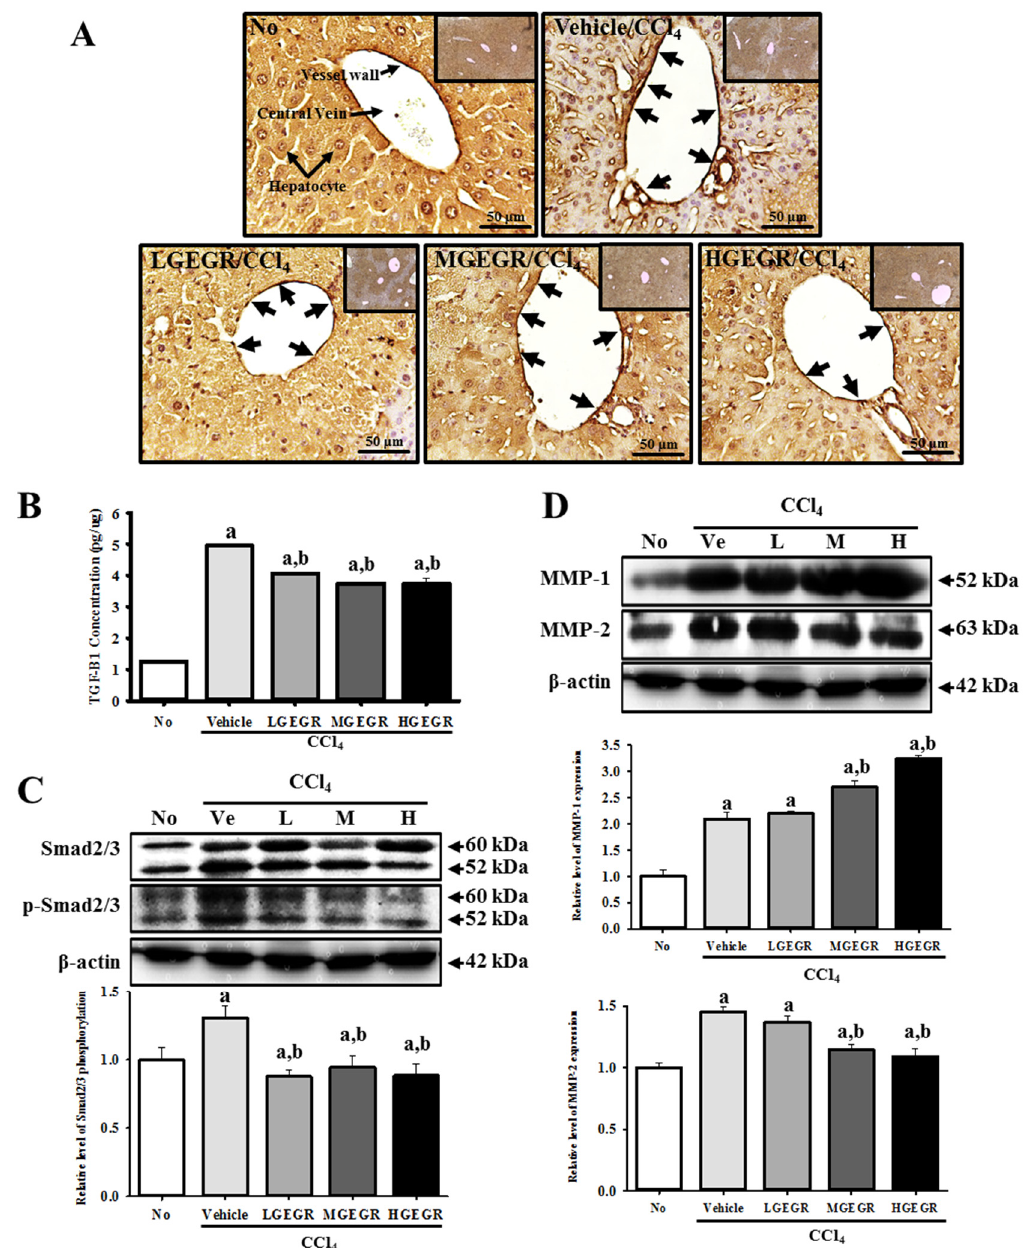
Figure 6. Analysis of the regulatory factors of liver fibrosis. ( A ) Immunohistochemistry of collagen protein. After GEGR/CCl4 pretreatment for 5 days, the liver tissues were collected from all groups and slide sections of liver were prepared as described in the Materials and Methods. The distribution of collagen protein in the slide sections of liver tissue was determined by staining with collagen specific antibody followed by observation at 400×. Black arrows indicate the stained area in THV; ( B ) ELISA for TGF ‐β 1. After collection of blood serum, the concentration of TGF ‐β 1 was determined in the serum collected from the brains of mice using a TGF ‐β 1 ELISA kit that could detect TGF ‐β 1 at 3.5 pg/mL; ( C ) Western blot analysis for Smad2/3 expression. To measure the expression levels of Smad2/3 and p ‐ Smad2/3 protein, the membranes were incubated with specific antibodies for each protein, as well as β‐ actin protein from liver lysates. Three mice per group were assayed by western blotting; ( D ) Western blot analysis of MMP expression. To measure the expression levels of MMP ‐ 1 and MMP ‐ 2 protein, the membranes were incubated with specific antibodies for each protein, as well as β‐ actin protein from liver lysates. Three mice per group were assayed by western blotting. Values are reported as the means ± SD. a, p < 0.05 compared to the no treatment group; b, p < 0.05 compared to the vehicle/CCl 4 treated group.